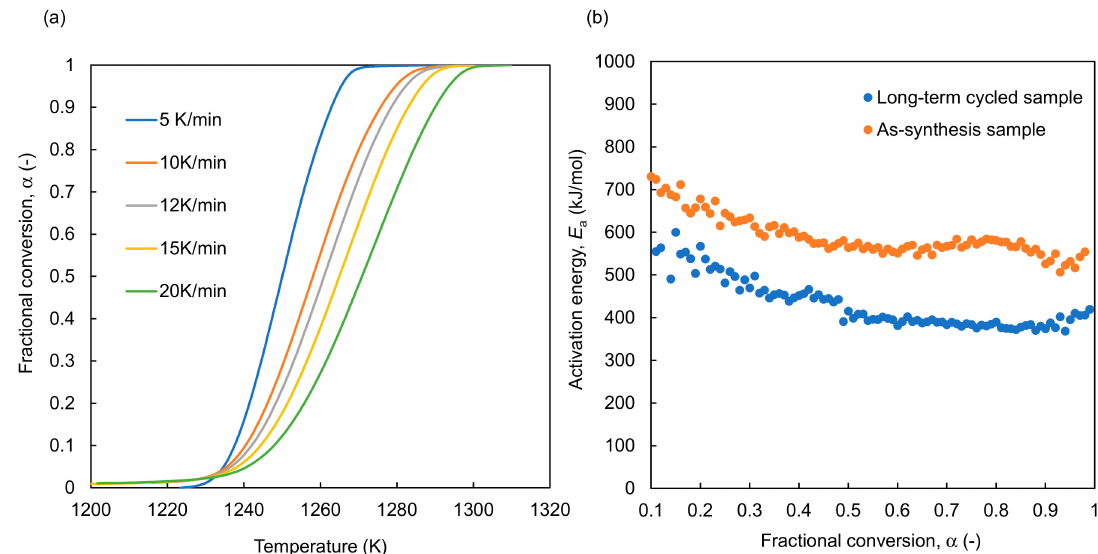
Figure 7. ( a ) Temperature variations in the fractional conversion of the as-prepared sample during the HC mode. ( b ) Variations in the apparent activation energy of the as-prepared sample against the fractional conversion. For comparison, the apparent activation energy of the long-term cycles sample is shown in this